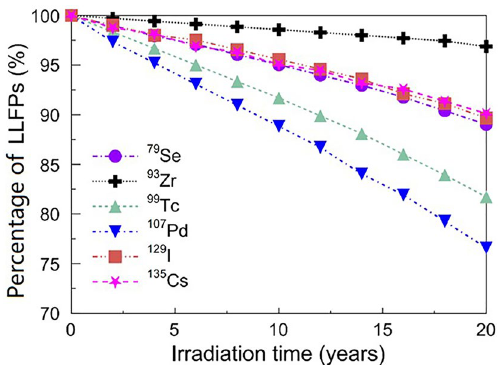
Figure 7. Percentage of LLFPs remaining in the core over a 20-year irradiation